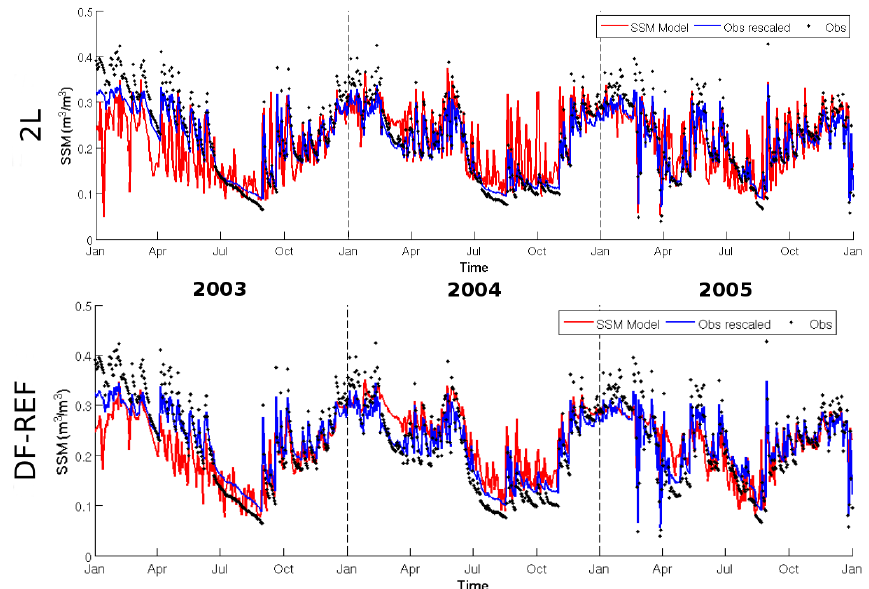
Fig. 3. Time series of SSM observations (black dots), w 1 modeled (red lines) and SSM observations rescaled after CDF matching (blue lines) for ISBA-2L (top) and ISBA-DF (bottom).